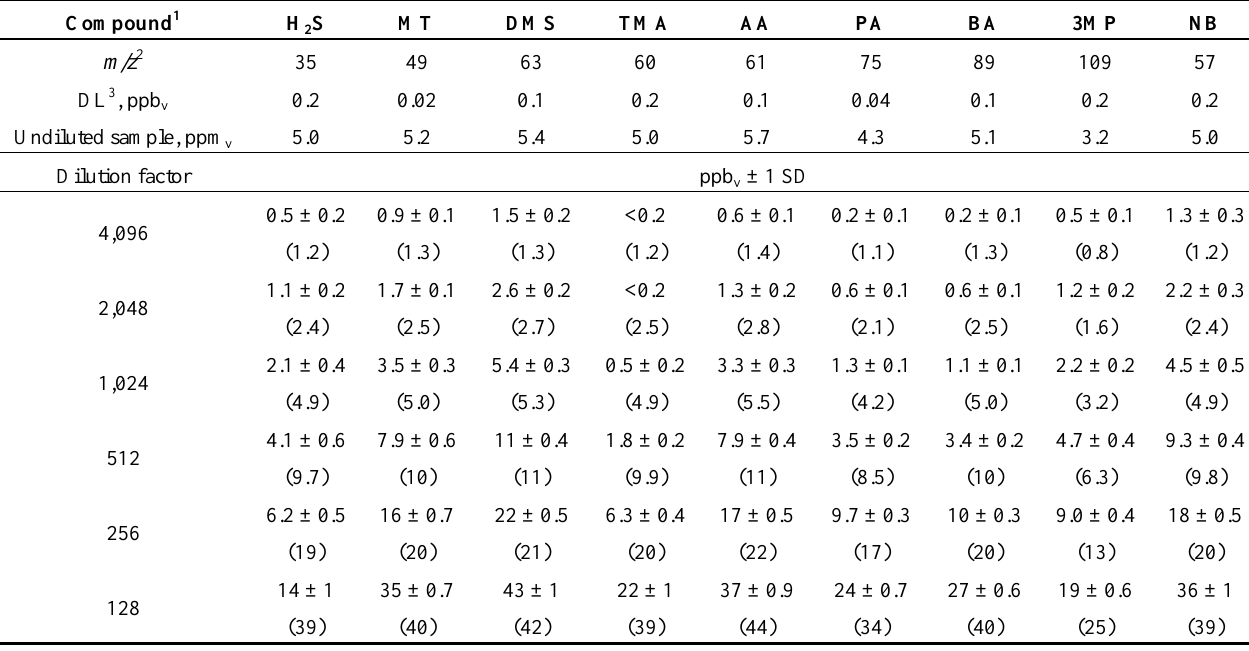
Table 1. Concentrations of odorants prior to dilution in the olfactometer and the concentrations measured at each dilution step by PTR-MS. The expected concentrations are shown in